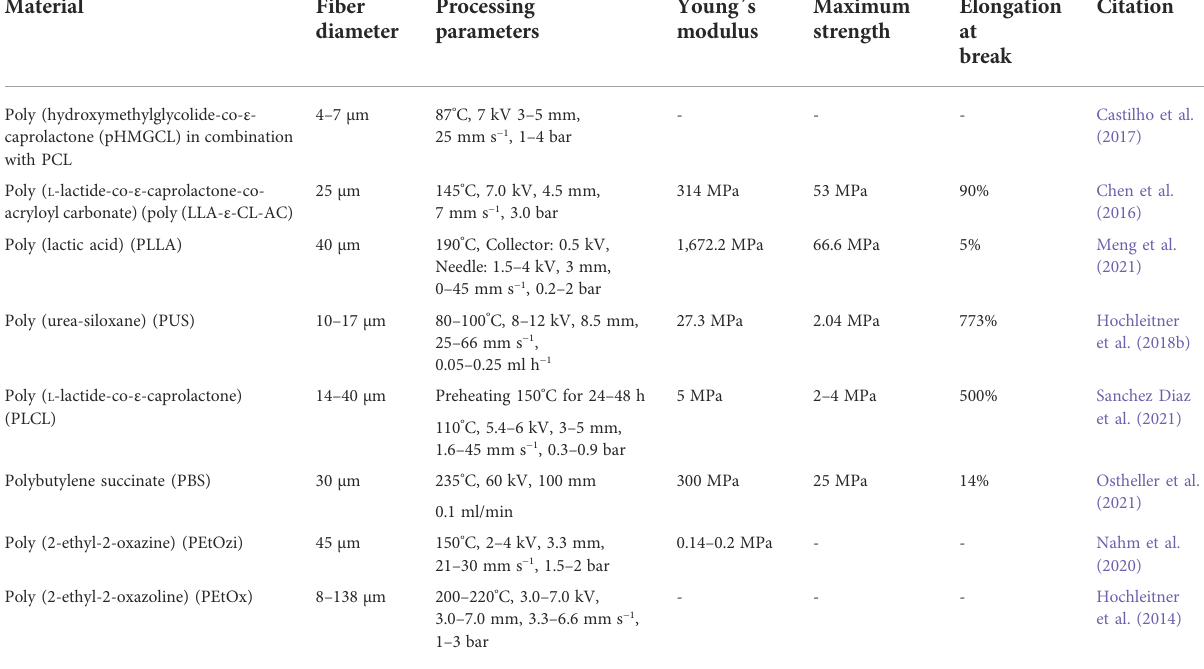
TABLE 3 Materials used in MEW: Different materials used in MEW for Scaffold fabrication or medical implants. Indicated are the processing temperature(in ° C), thevoltage(inkV),the distance between collector andnozzle(in mm),the printing speed (in mm s − 1 ) andthematerial fl ow(in ml min − 1 or